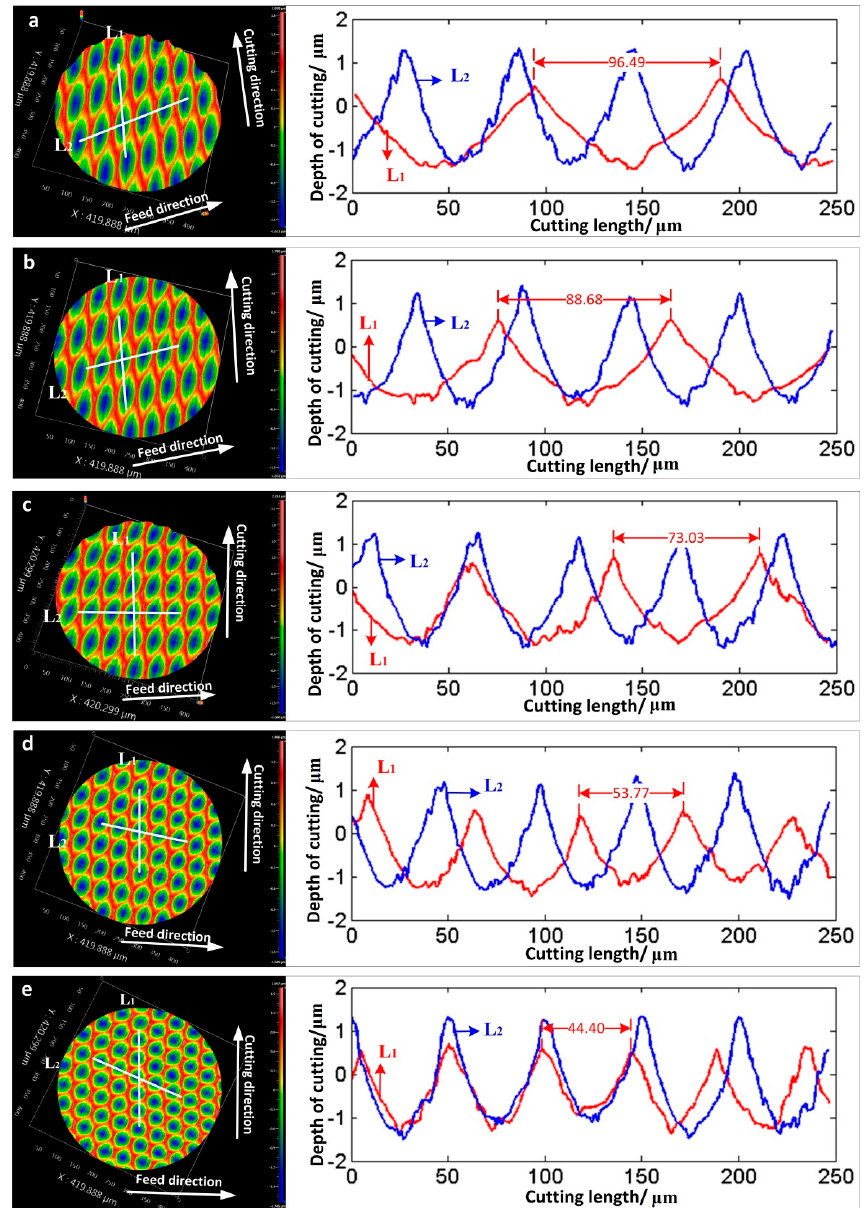
Figure 8. Effect of cutting speed on surface topography machined by a non-resonant three- dimensional elliptical vibration cutting (3D-EVC) apparatus and the section contours along the cutting direction (Red line L 1 ) and feed direction (Blue line L 2 ), respectively ( f 3D = 50 Hz, A = 7 μ m, D = 1 μ m and F = 0.2 mm·min − 1 ). ( a ) S = 70 mm/min; ( b ) S = 60 mm/min; ( c ) S = 50 mm/min; ( d ) S = 40 mm/min; ( e ) S = 30 mm/min.